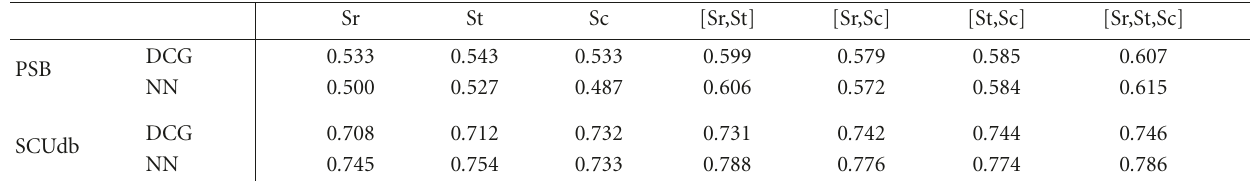
Table 8: DCG and NN scores for the combination of density-based descriptors.